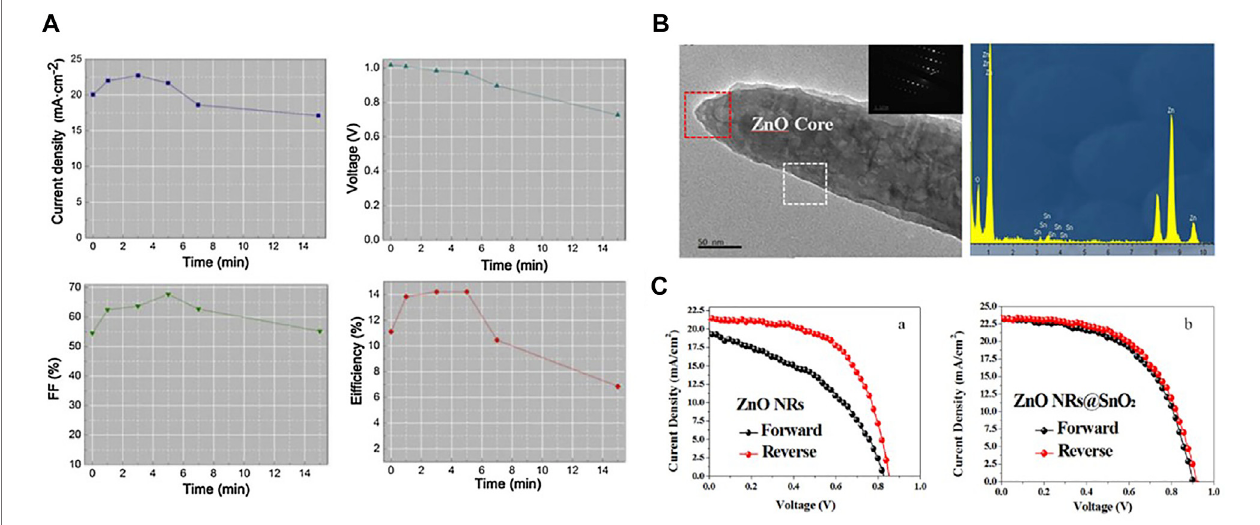
FIGURE 7 | (A) Effect of the length of ZnO nanorods on the photovoltaic performance parameters of devices (short-circuit current density, open-circuit voltage, fi lling factor, photoelectric conversion ef fi ciency). (B) The TEM image and simultaneous energy-dispersive spectroscopy (EDS) of SnO curves of PSCs with the bare ZnO substrate and the SnO 2 doped ZnO nanorod substrate which are measured by forward and reverse scan